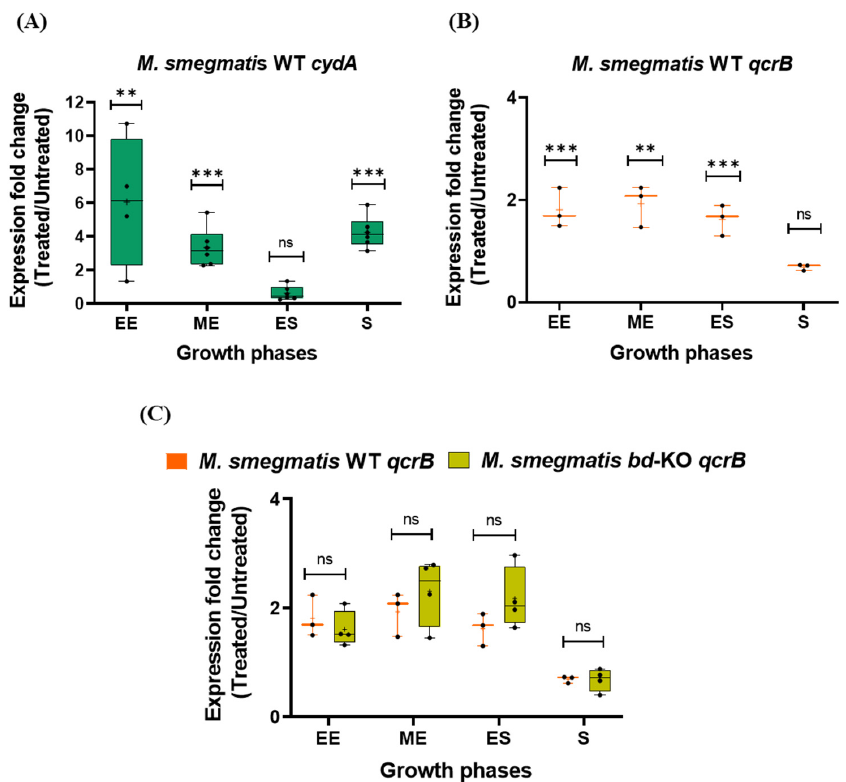
Figure 4. Transcriptional regulation of terminal oxidases of Mycobacterium smegmatis in presence of Q203. Fold change in expression of ( A ) the cydA gene and ( B ) the qcrB gene of M. smegmatis WT in Q203-treated versus untreated cultures was assessed in different growth phases by RT-qPCR (using 16S rRNA as control). ( C ) Comparative analysis of fold change expression of qcrB gene in M.